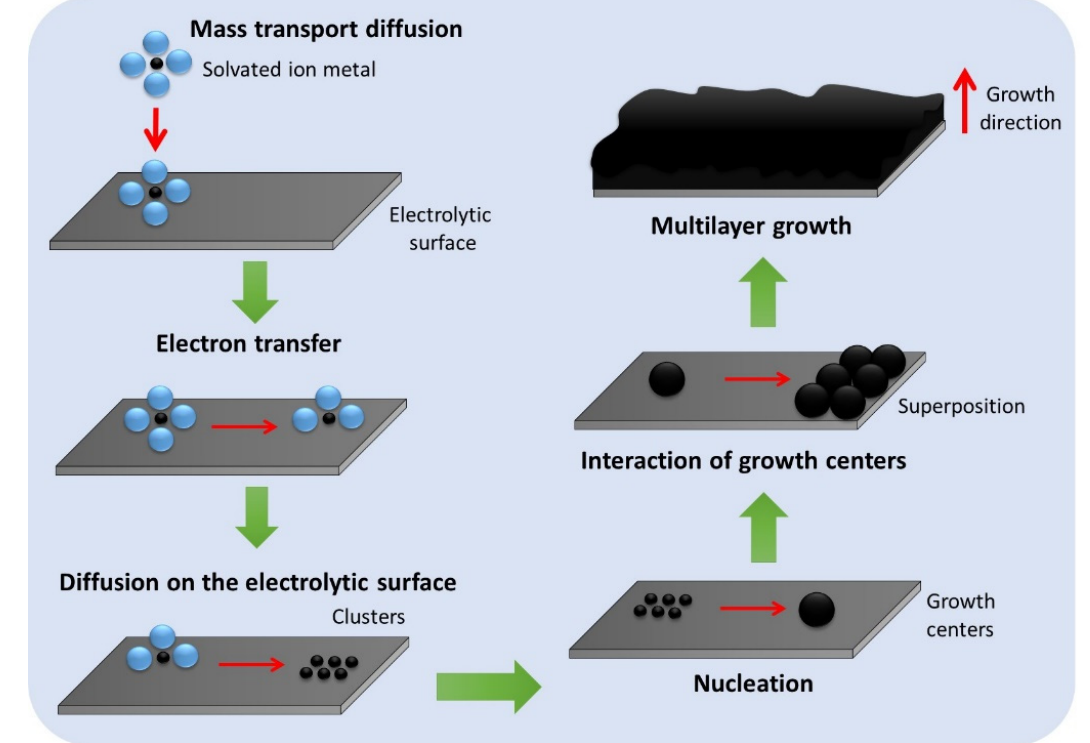
Figure 1. Deposit formation process and its involved phenomena.